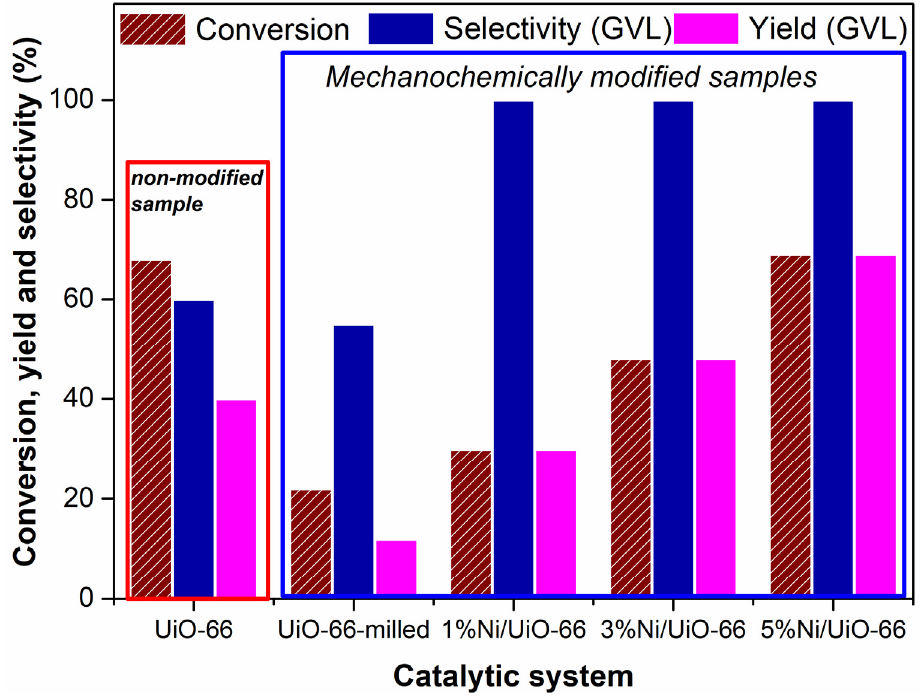
Figure 4. Comparative analysis of the catalytic performance in terms of conversion of methyl levulinate, selectivity and yield towards GVL of UiO-66, 1%Ni/UiO-66, 3%Ni/UiO-66, 5%Ni/UiO-66.